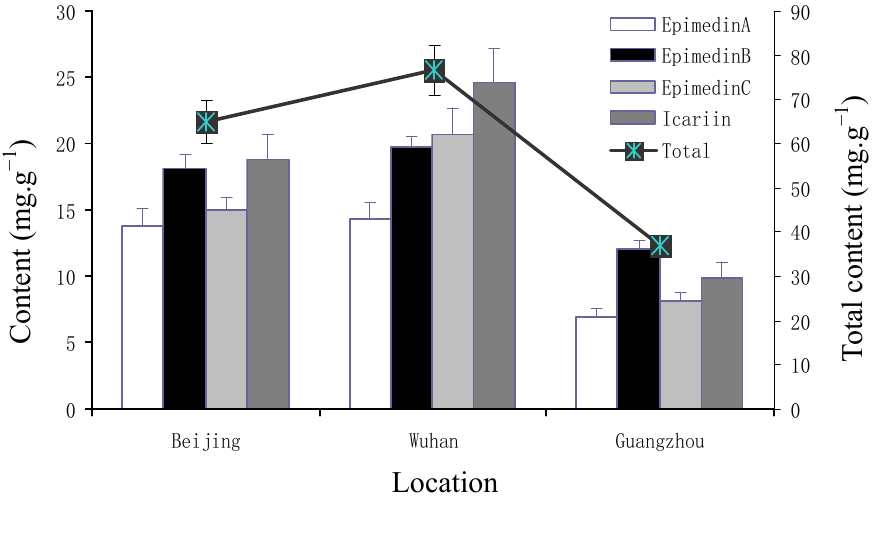
Figure 6. Contents of the four flavonoids in LT race planted in the three gardens (Beijing, light intensity 50–180 μ mol/m 2 /s; Wuhan, light intensity 60–160 μ mol/m 2 /s; Guangzhou, light intensity 55–170 μ mol/m 2 /s). Values shown are mean for contents in the three years. The two axes of coordinates represent the content of each flavonoid and the total of the four flavonoids (epimedin A, B, C, and icariin). Bars are standard